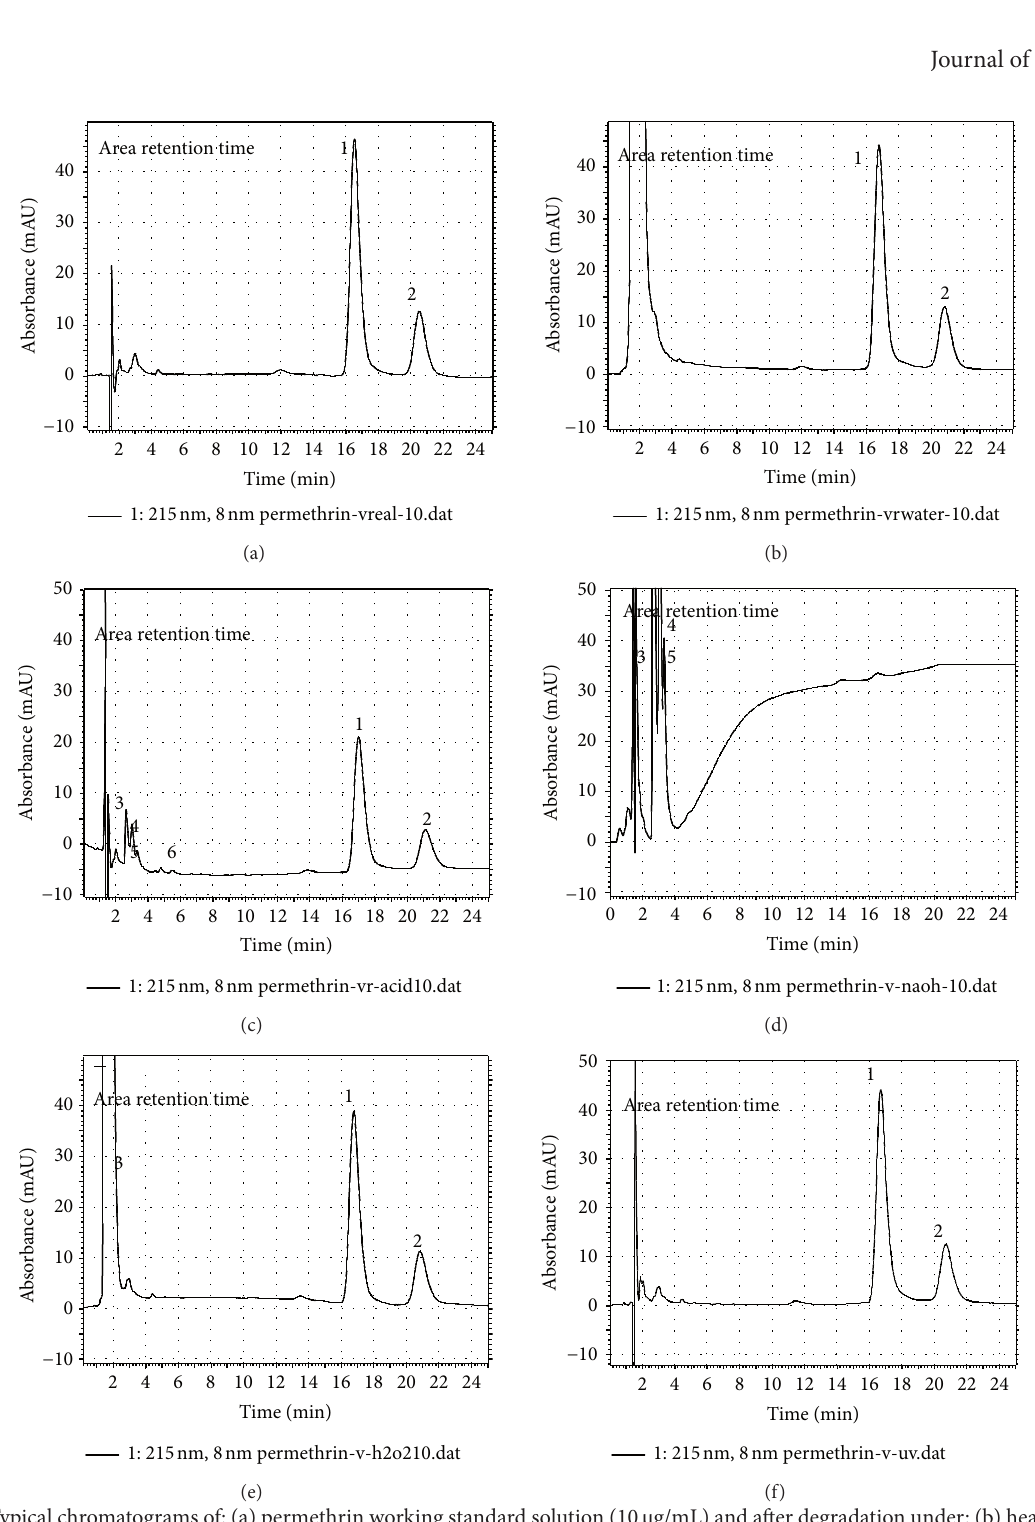
g/mL) and aer degradation under: (b) heat condition; μ